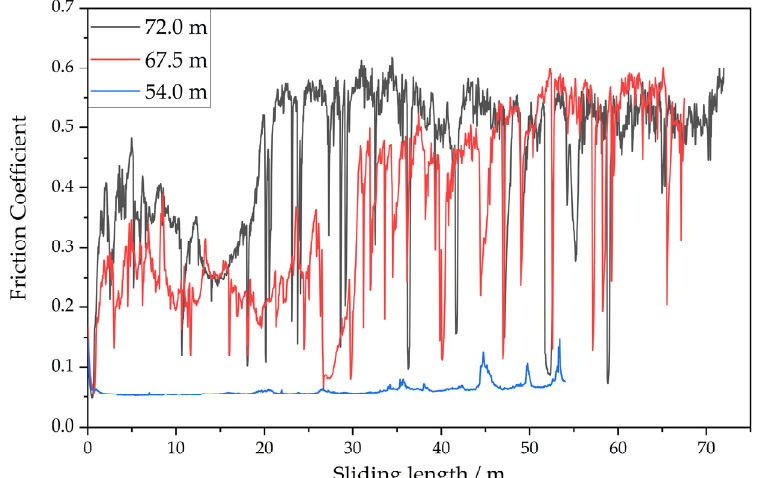
Figure 5. COF for the long-term experiments of the ta-C/brass pairing under high vacuum, with an equivalent sliding distance of 54.0 m, 67.5 m and 72.0 m. The long-term degradation of friction is visible in two experiments.